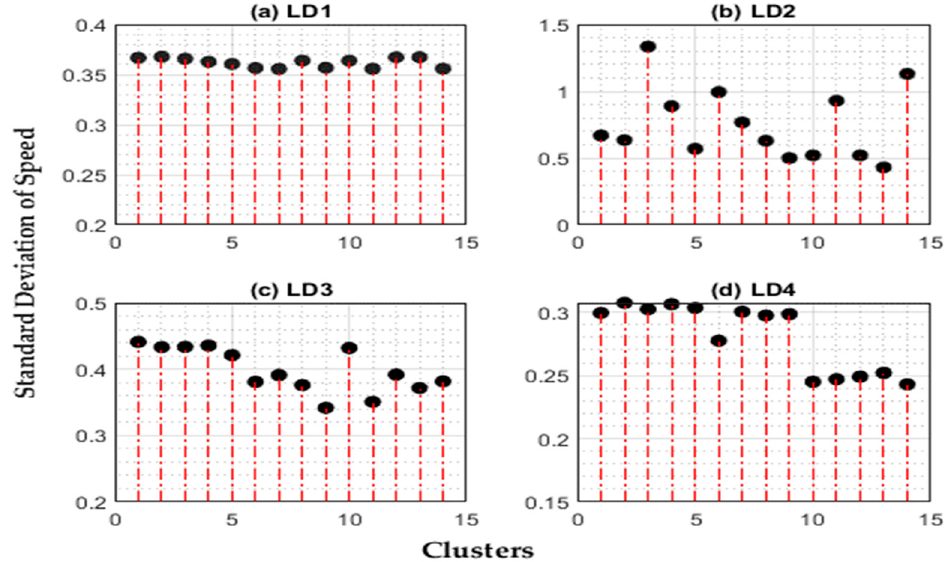
Figure 16. RK-Means standard deviation of speed in low-density scenarios.